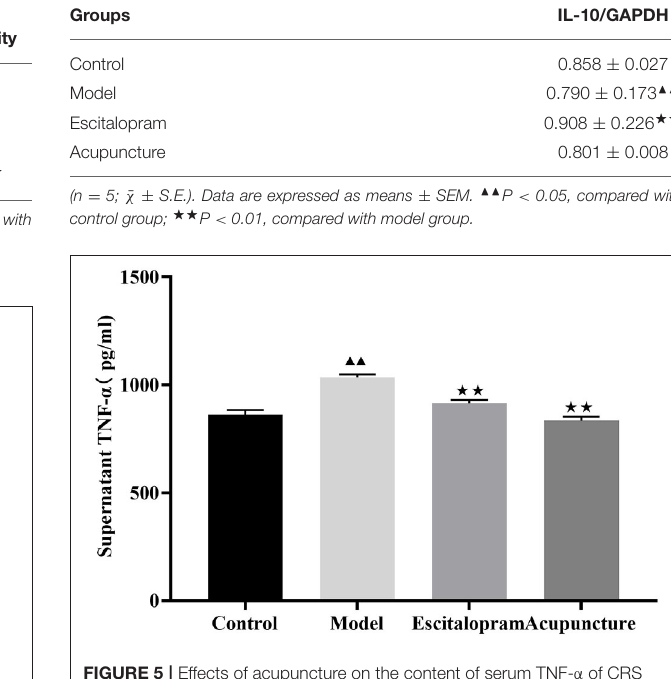
FIGURE 5 | Effects of acupuncture on the content of serum TNF- α of CRS rats. Data are expressed as means ± S.E.M. ( n = 5). NN P < 0.01, compared with control group; ⋆⋆ P < 0.01, compared with model group. One-way ANOVA followed by LSD’s post-hoc test.